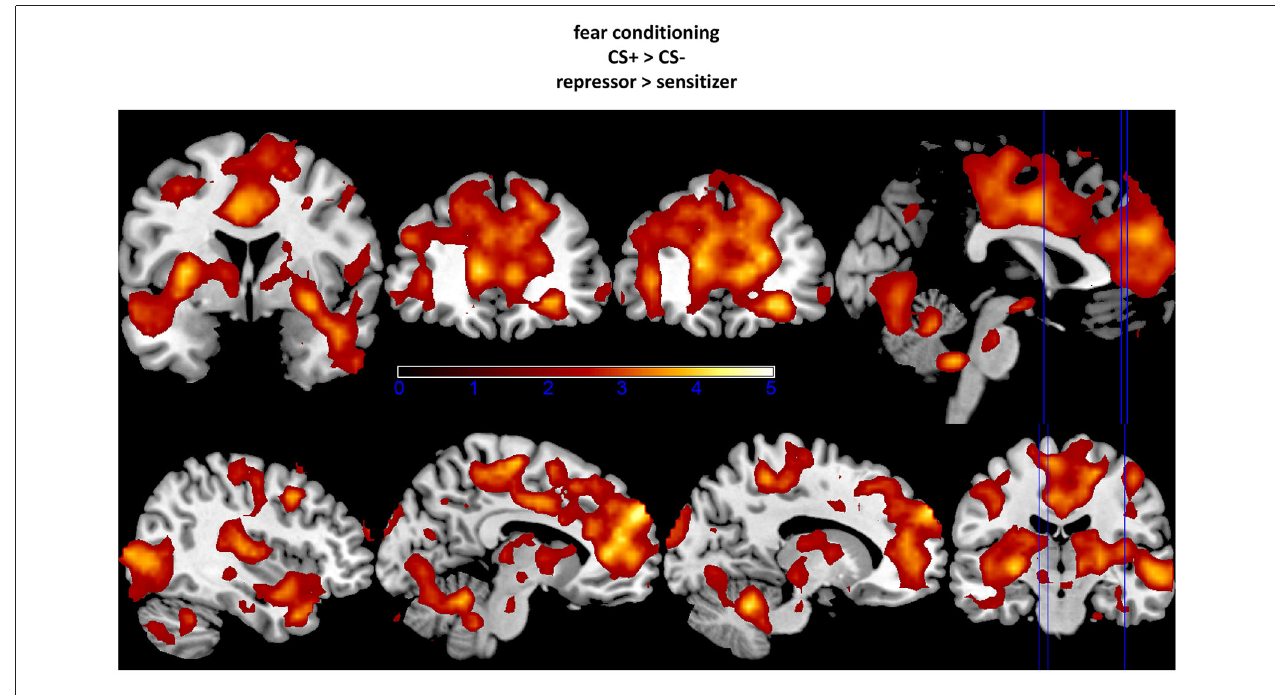
FIGURE 2 | Increased activation in amygdala, insula, and orbitofrontal cortex (OFC; upper part) as well as in occipital cortex (OCC), anterior cingulate cortex (ACC), and vmPFC